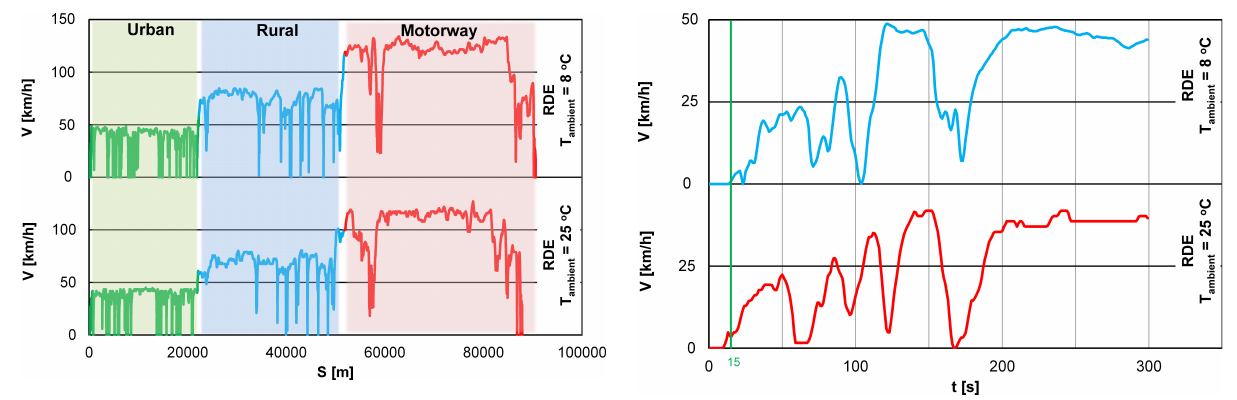
Figure 2: Vehicle velocity of individual route tests